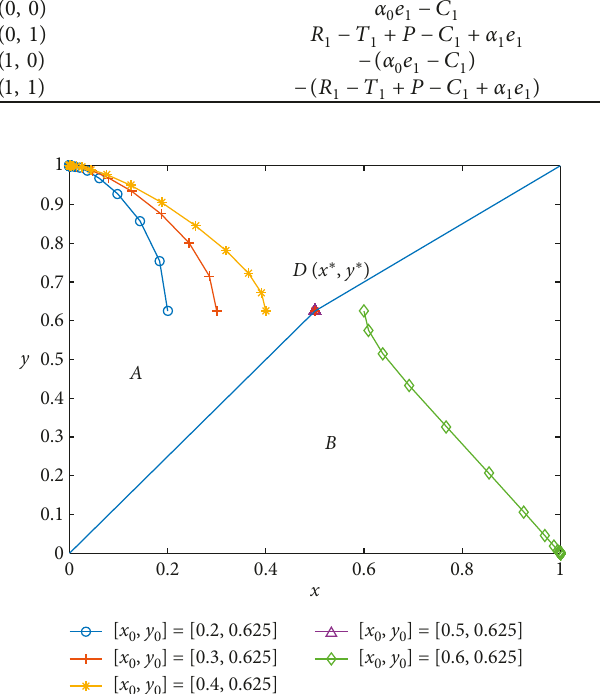
Figure 2: Influences of the changes in the initial value x evolutionary result.